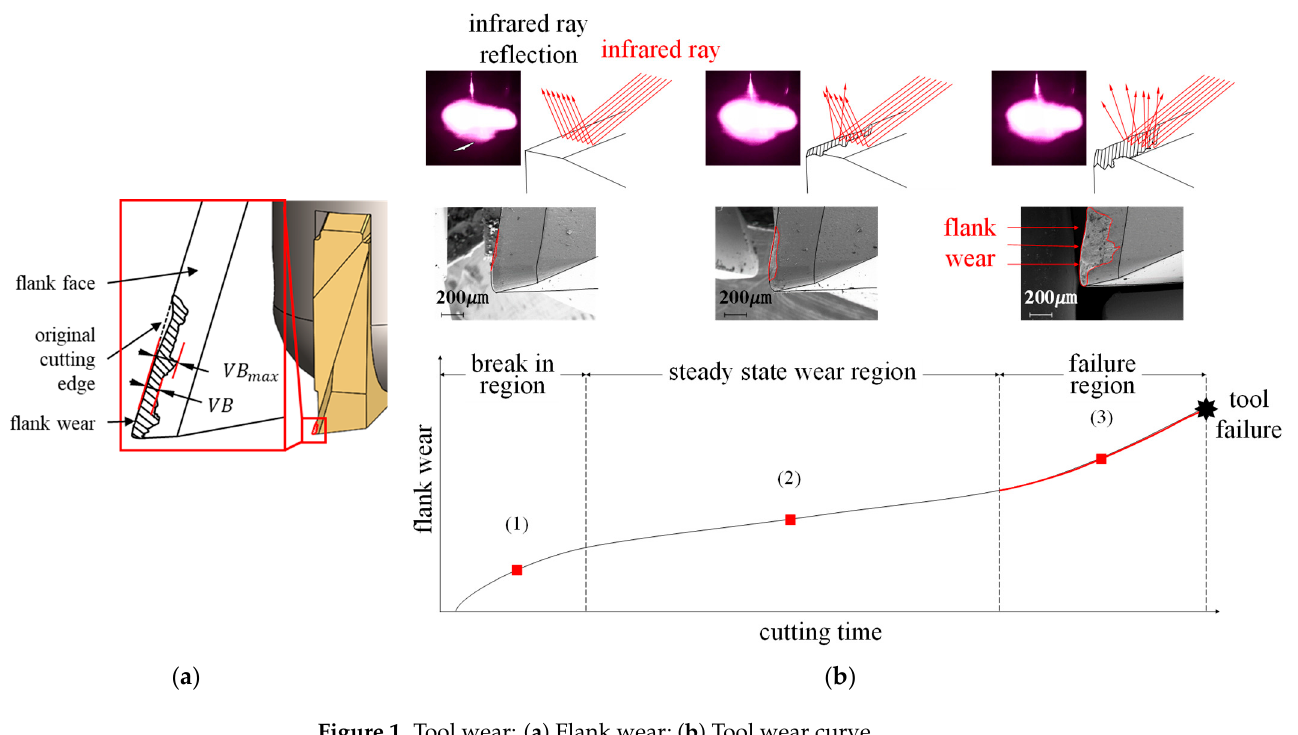
Figure 1. Tool wear: ( a ) Flank wear; ( b ) Tool wear curve.